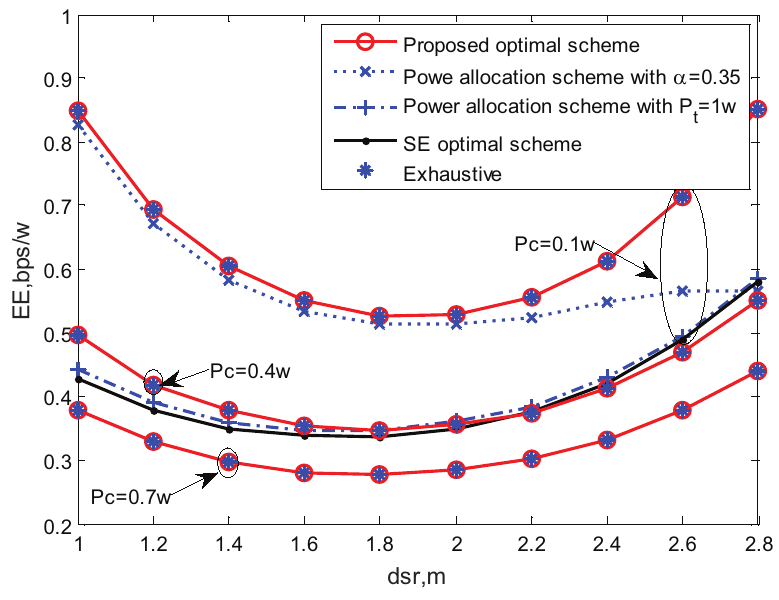
Figure 6. EE versus d 1 when d 2 = 3 − d 1